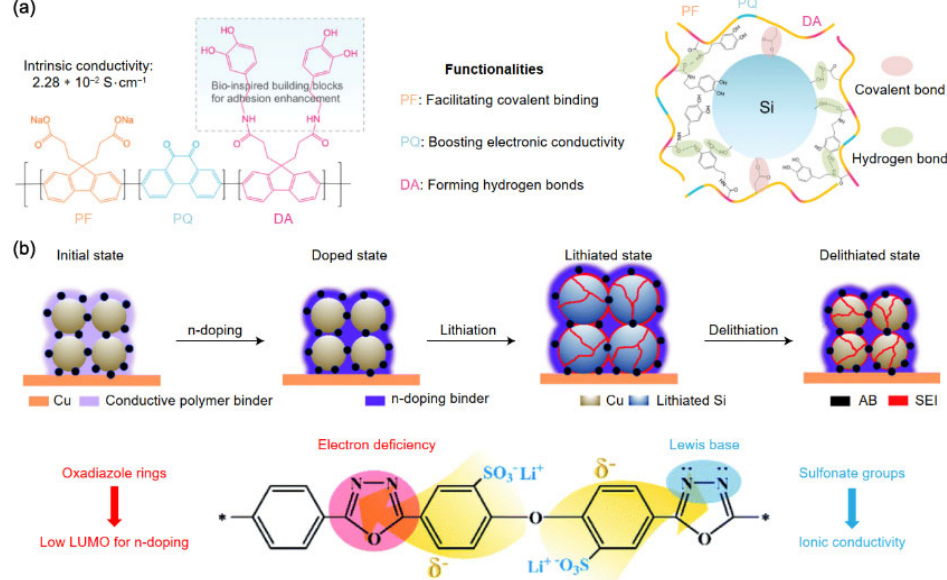
Figure 10 (a) Molecular structure of PFPQDA and the illustration of functionalities of each moiety in the monomeric unit Scheme of multiple networks constructed within Si/PFPQDA electrodes. Reproduced with permission from Ref. [150], © Wiley-VCH GmbH 2022. (b) n-Type CPB that maintains the electrical and mechanical integrity of the SiMP anode during charge and discharge cycles and the chemical structure of aromatic polyoxadiazole lithium sulfonate. Reproduced with permission from Ref. [151], © The Royal Society of Chemistry